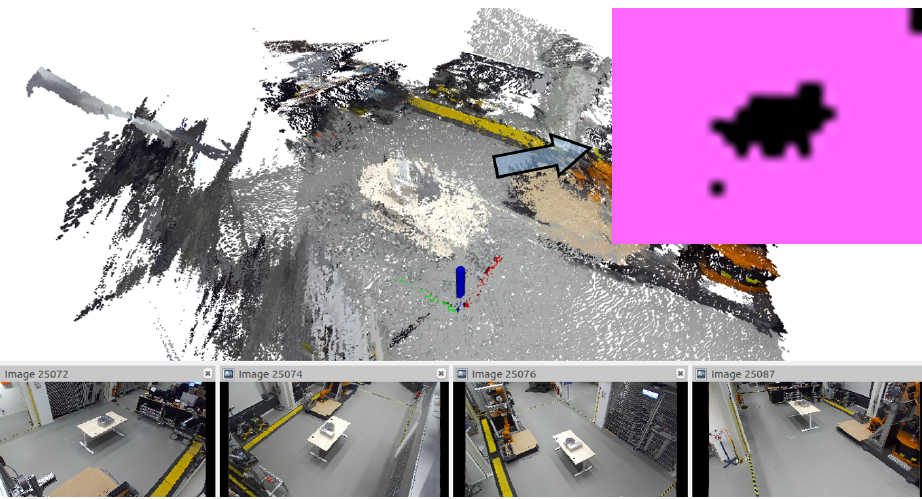
Figure 7. Projection of the foreground point cloud onto a ground-parallel image plane (pink back- ground image). The figure depicts the full merged point cloud. The ROI is set to 2 × 2.5 m centered around the table. Foreground pixels are colored